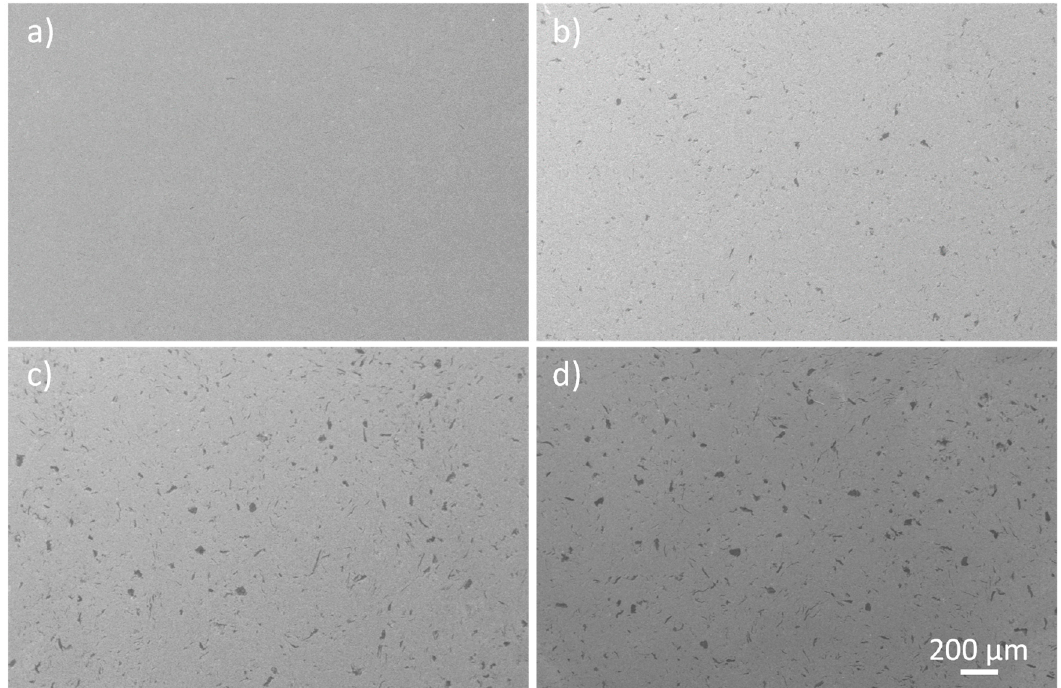
Figure 1. Scanning electron microscopy (SEM) images of ( a ) Cu–1Gr, ( b ) Cu–2Gr, ( c ) Cu–3Gr, and ( d ) Cu–4Gr.